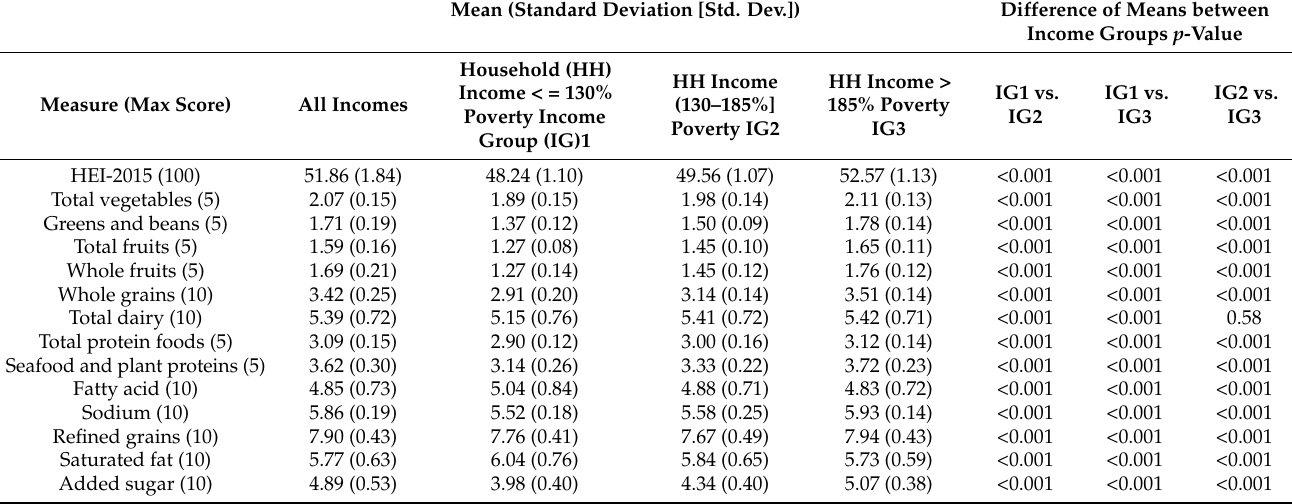
Note: Adjusted for household race and ethnicity; household head’s age and marital status; and female-led household. Unadjusted measures are omitted for brevity but can be obtained from the authors upon request.